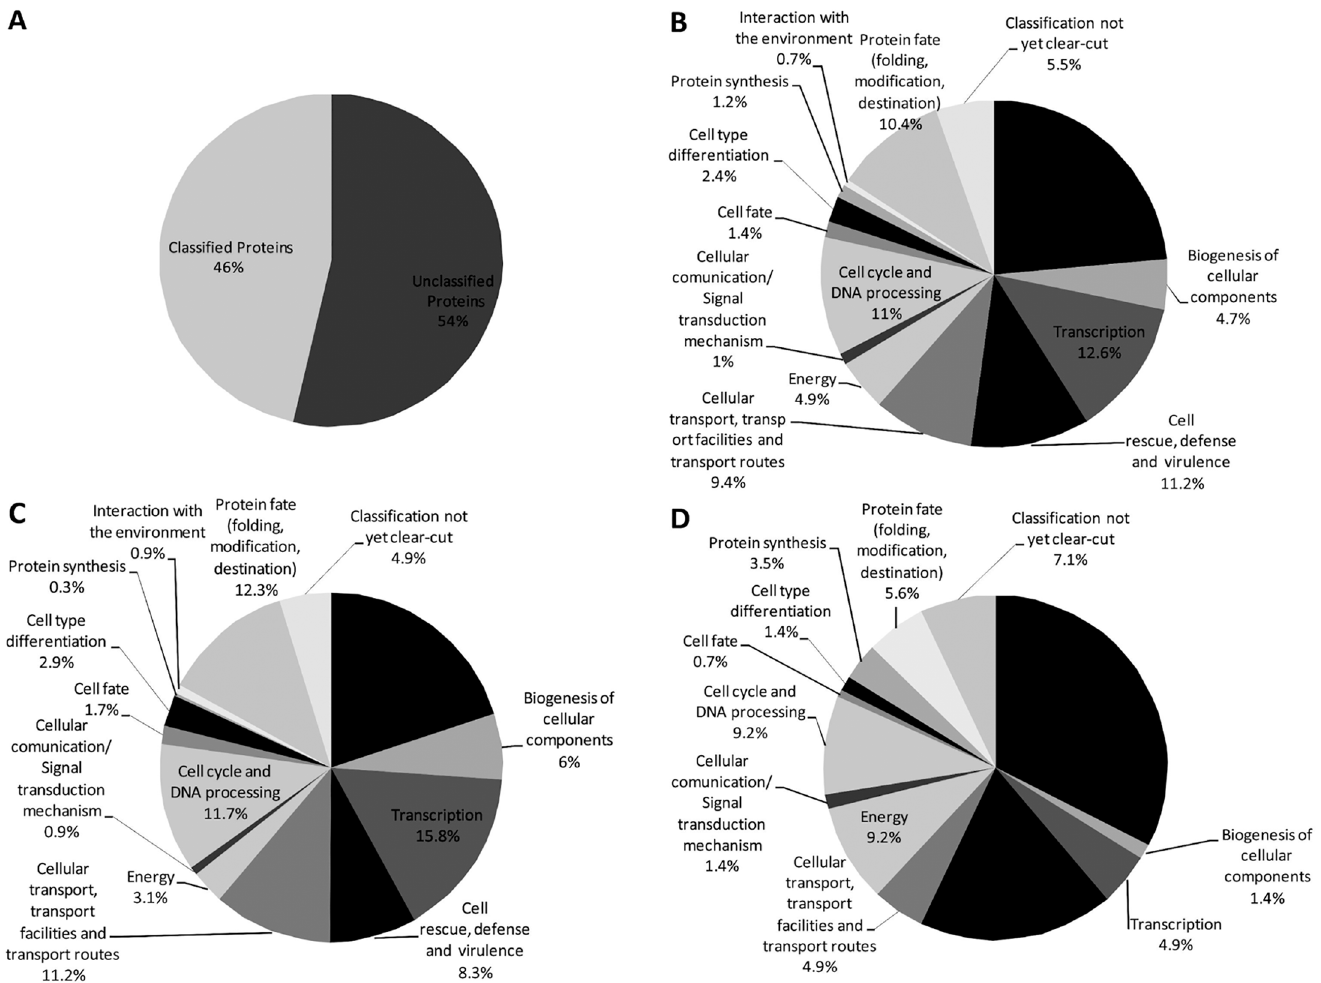
Fig 1. Functional classification and abundance levels of transcripts regulated in Paracoccidioides lutzii in the presence of argentilactone obtained by RNAseq. (A) Total transcripts represented by classified and unclassified categories; (B) Genes differentially expressed in the presence of argentilactone; (C) Down-regulated genes in the presence of argentilactone; (D) Up-regulated genes in the presence of argentilactone. Counting the number of reads for each gene in the genome annotated reference was applied to a statistical analysis using a Fisher's exact test for the identification of genes with differential